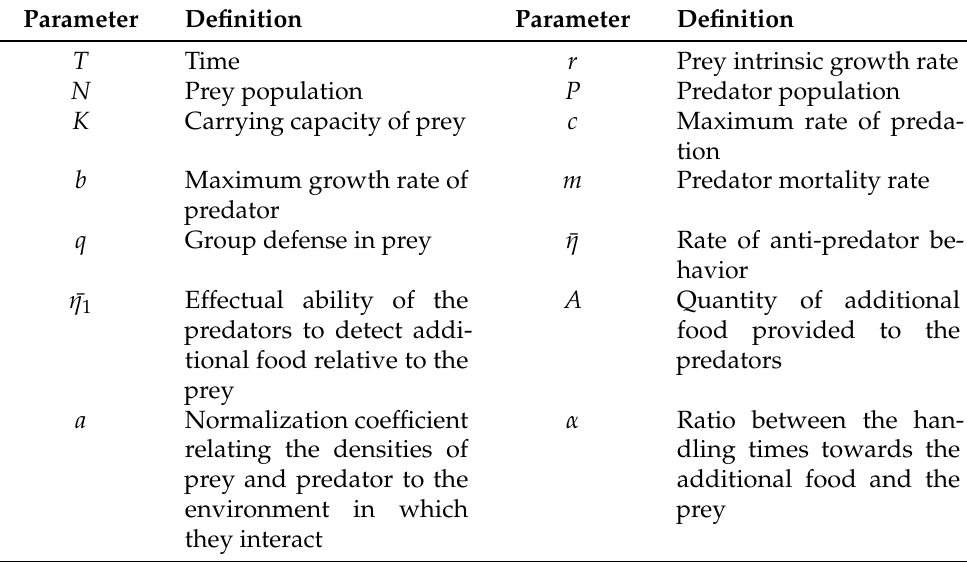
Table 1. Biological description of parameters in model